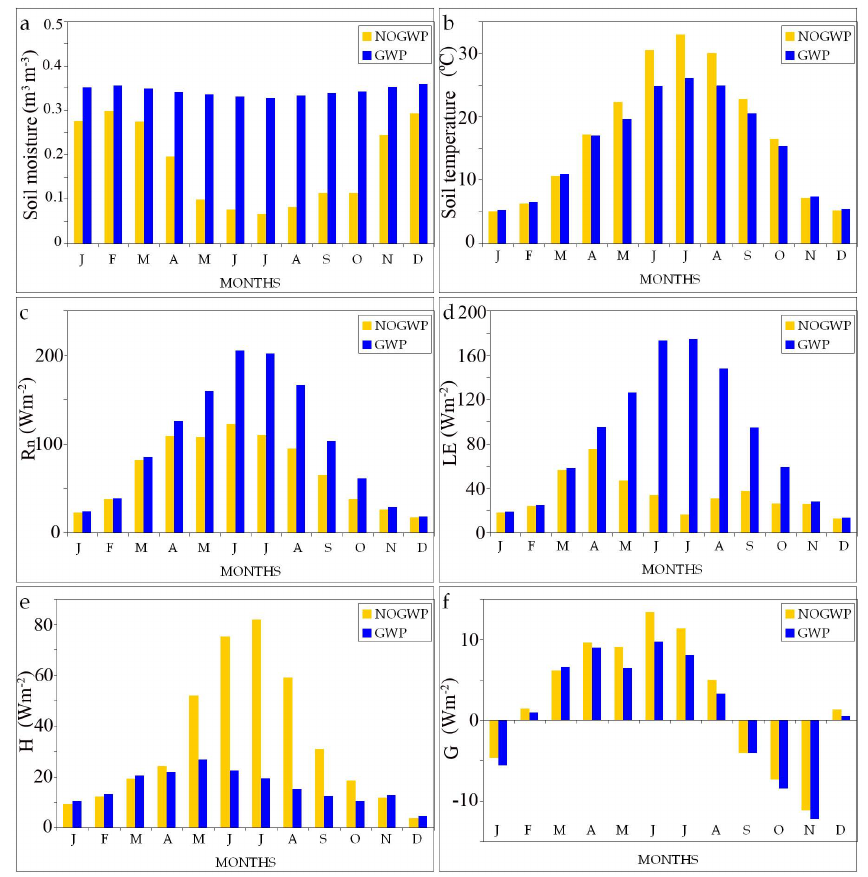
Fig. 3. The monthly averaged values of the surface soil moisture, the surface soil temperature and the surface energy balance components of the simulated